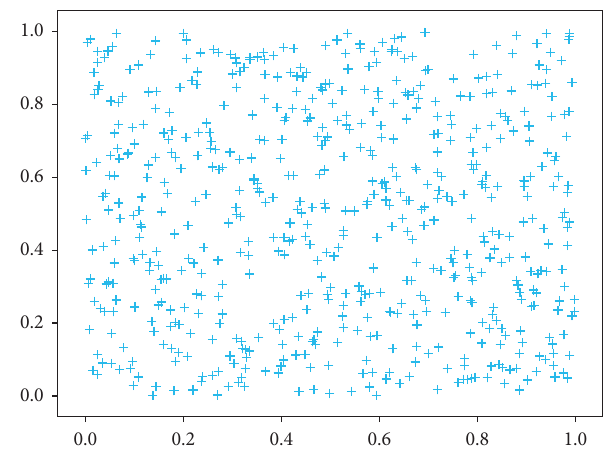
Figure 3: Two-dimensional initial populations generated by the random method ( N �